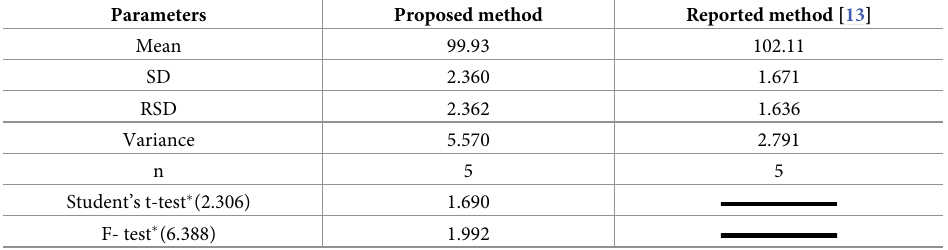
Table 4. Statistical comparison of the results obtained by the proposed method and the reference method [13] for the determination of LAP in bulk powder.